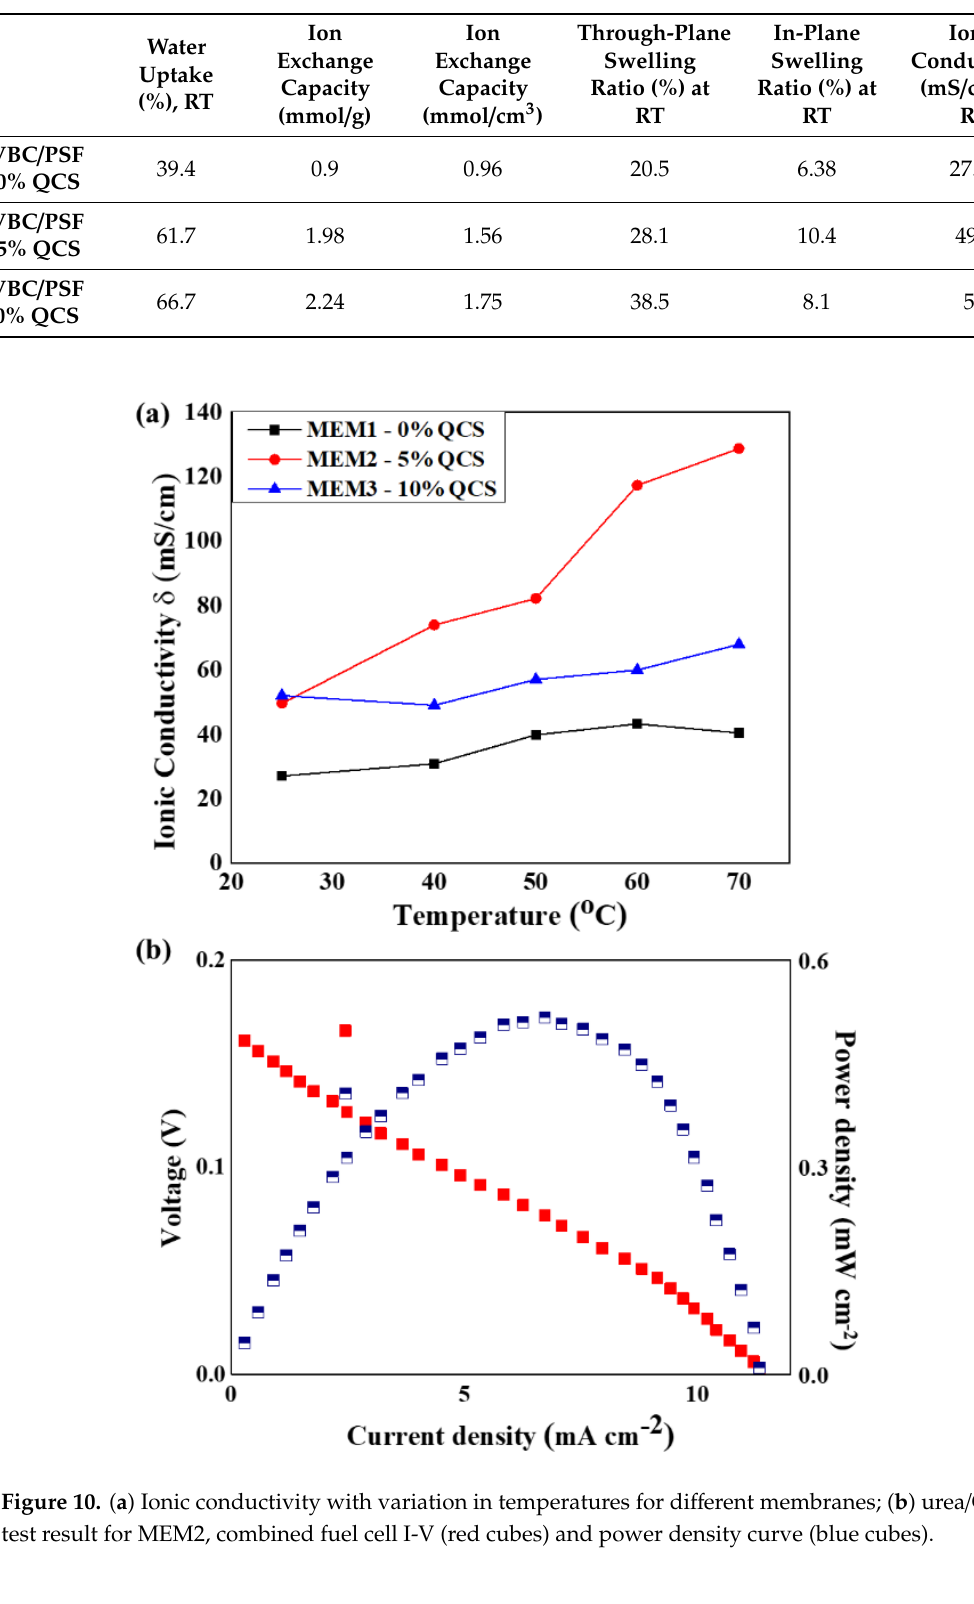
Table 1. Properties of membranes.